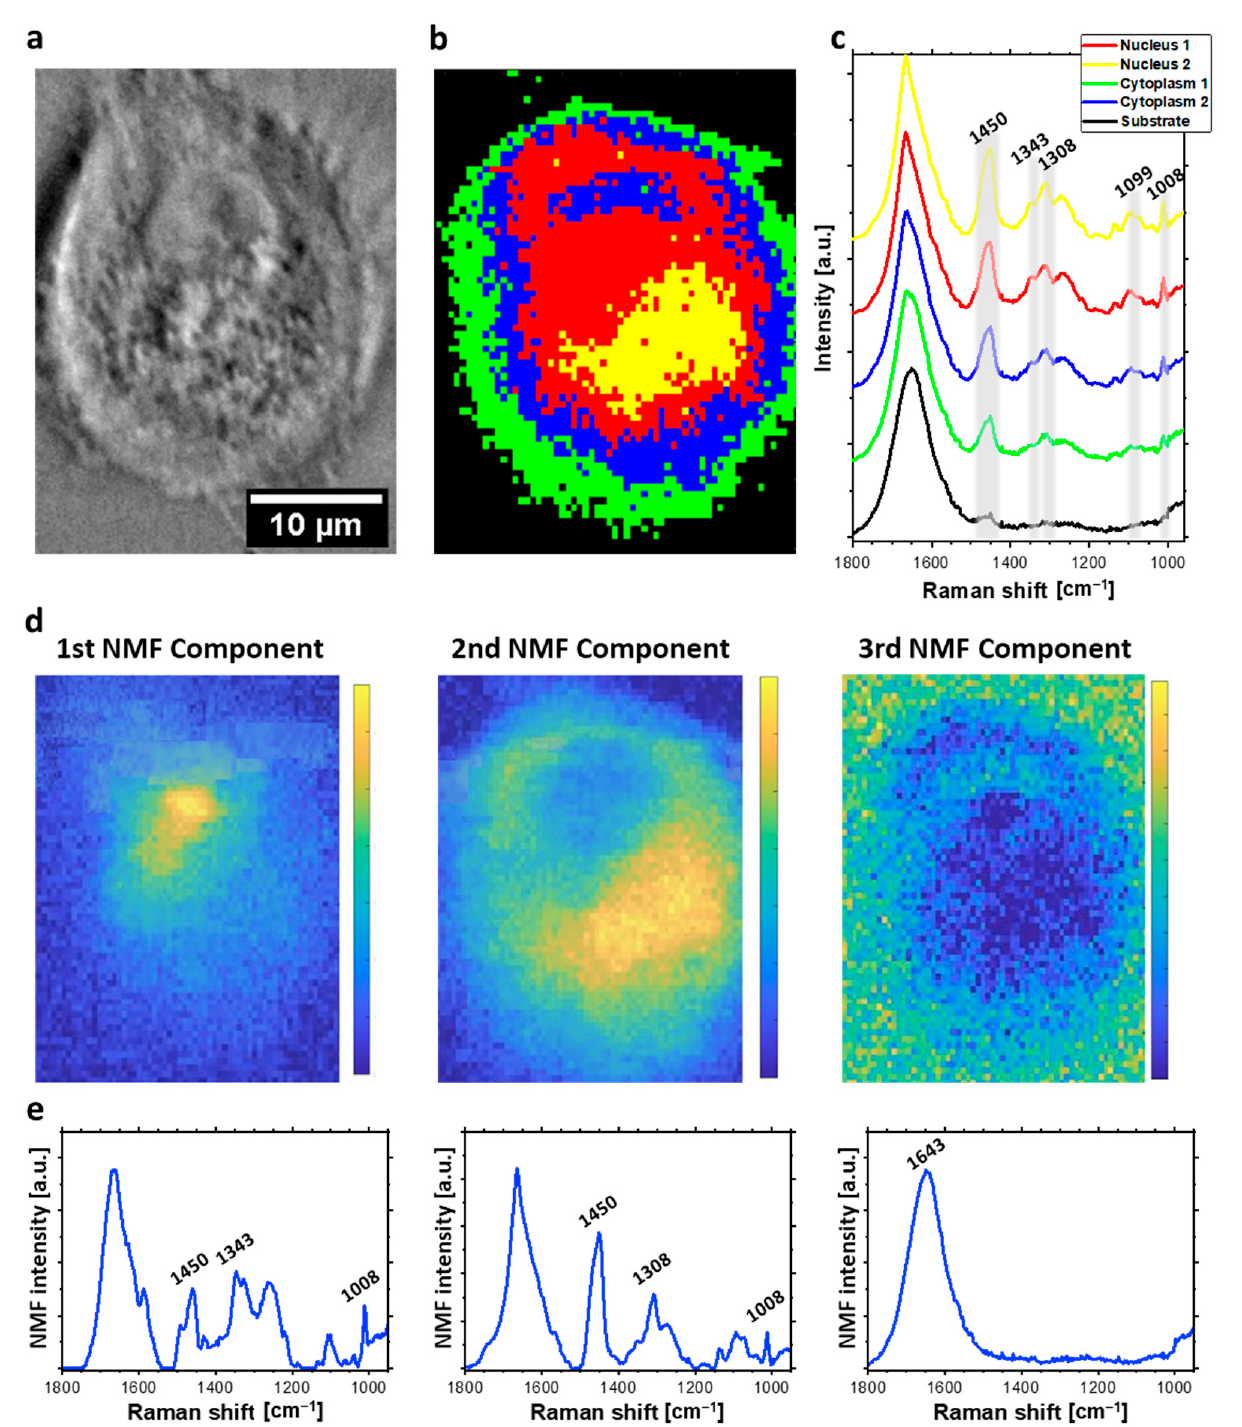
Figure 4. Raman imaging of apoptotic HeLa cell incubated with 500 µM for 24 h. ( a ) Cell optical image; ( b ) HCA map; ( c ) HCA mean Raman spectra (color of each spectrum corresponds to color of the cluster in ( a )); ( d ) false-color image NMF maps of three components distribution; ( e ) corresponding plots of NMF components.